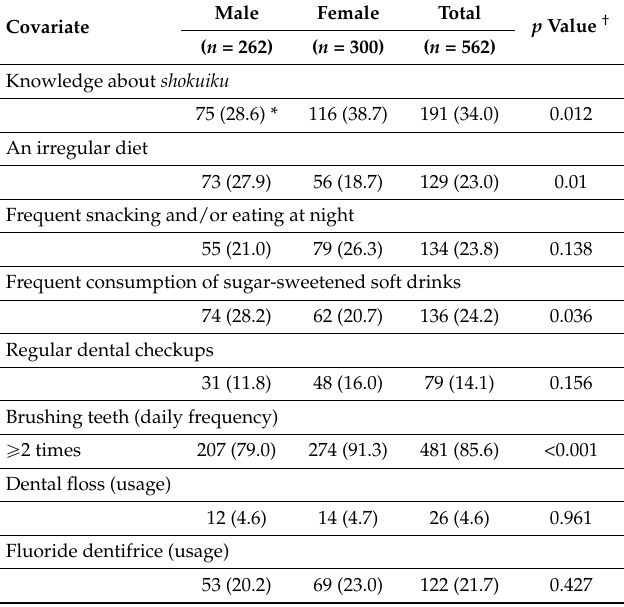
Table 1. Sex differences in knowledge about comprehensive food education ( shokuiku ), dietary habits, and oral health behaviors at baseline.